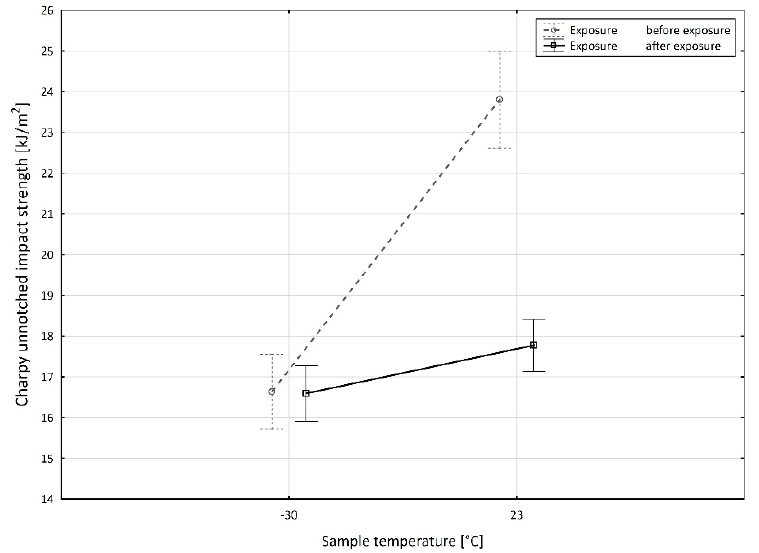
Figure 12. Dependence of the mutual interaction of the sample temperature and the exposure of the sample on the value of the unnotched impact strength of PPA.